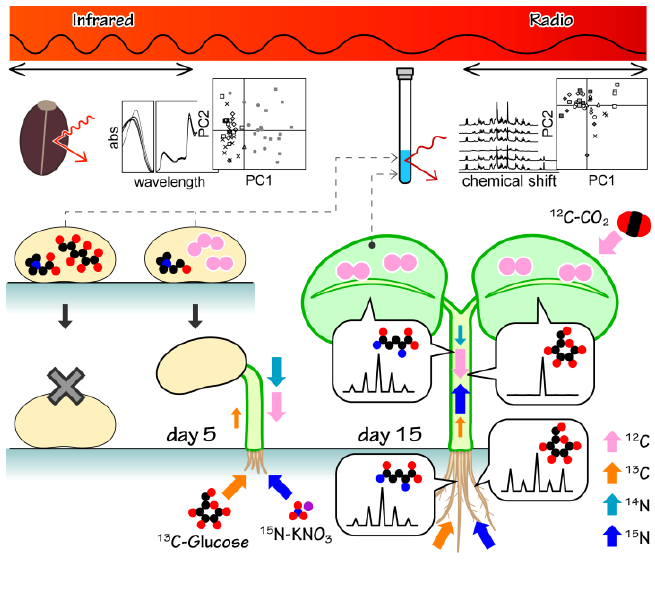
Figure 6. A schematic summary of the present study. Two spectroscopy using different wavelength (NIR and NMR) were applied to examine the viability of seeds of J. curcas. PCA score plots of NMR spectra showed oxidative reaction made seeds worsen. Stable-isotope labeling of germinated seedlings was carried out with agar-plate containing 13 C-glucose and 15 N-nitrate. Estimated isotope flows were indicated in arrows. NMR isotopic analysis was applied during their initial growth stage. Isotopic analysis indicated isotope flow from root to leaf was small. Isotopic pattern in 13 C-ditected 1 H- 13 C HETCOR indicated glutamine and arginine were the major organic compounds for nitrogen and carbon transfer from roots to